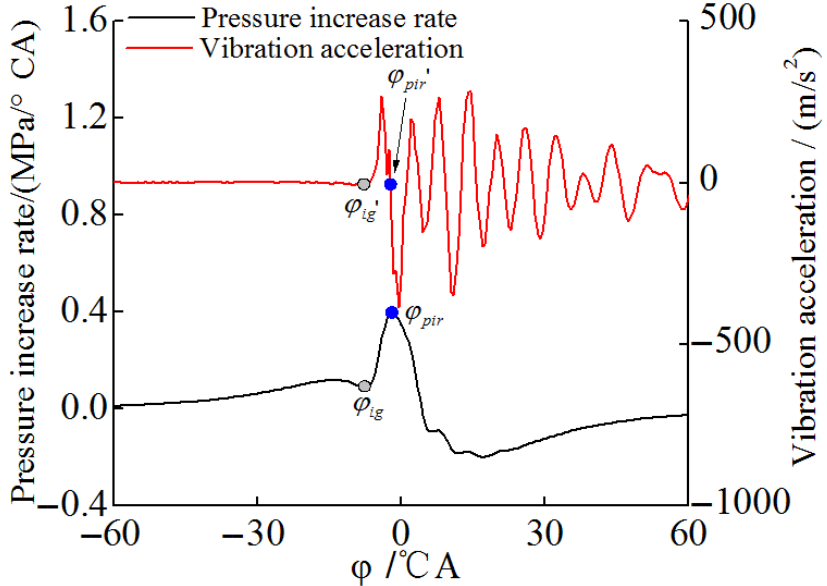
Figure 10. Comparison of PIR and vibration acceleration.